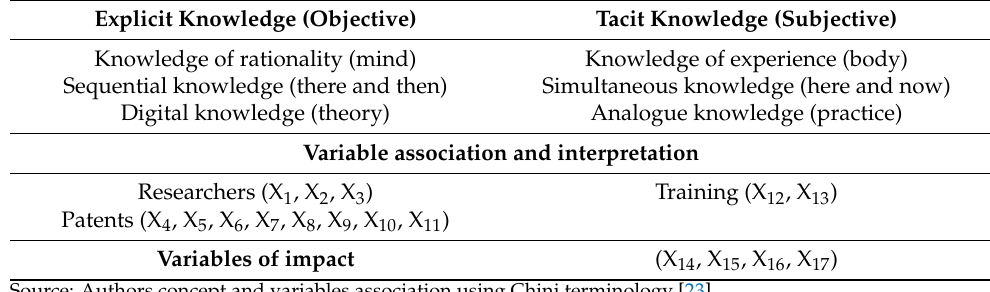
Table 1. Association of